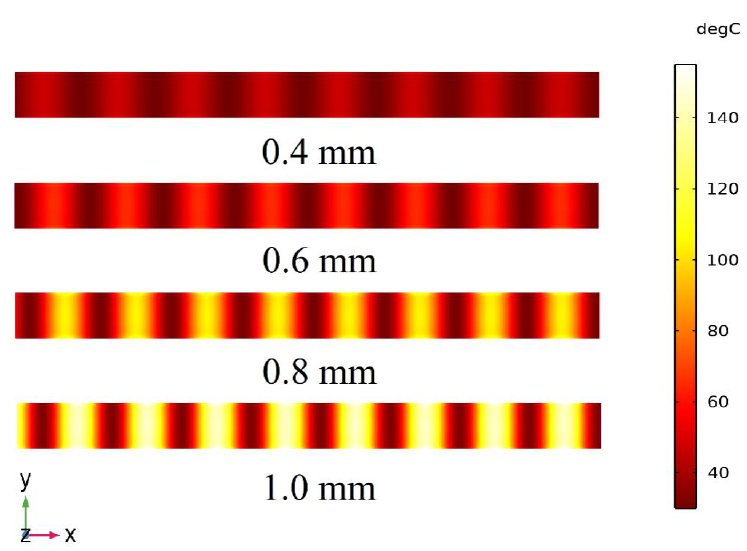
Figure 12. The temperature distribution of the films in the x–y plane. Table 4. The heating performance of different film thicknesses.